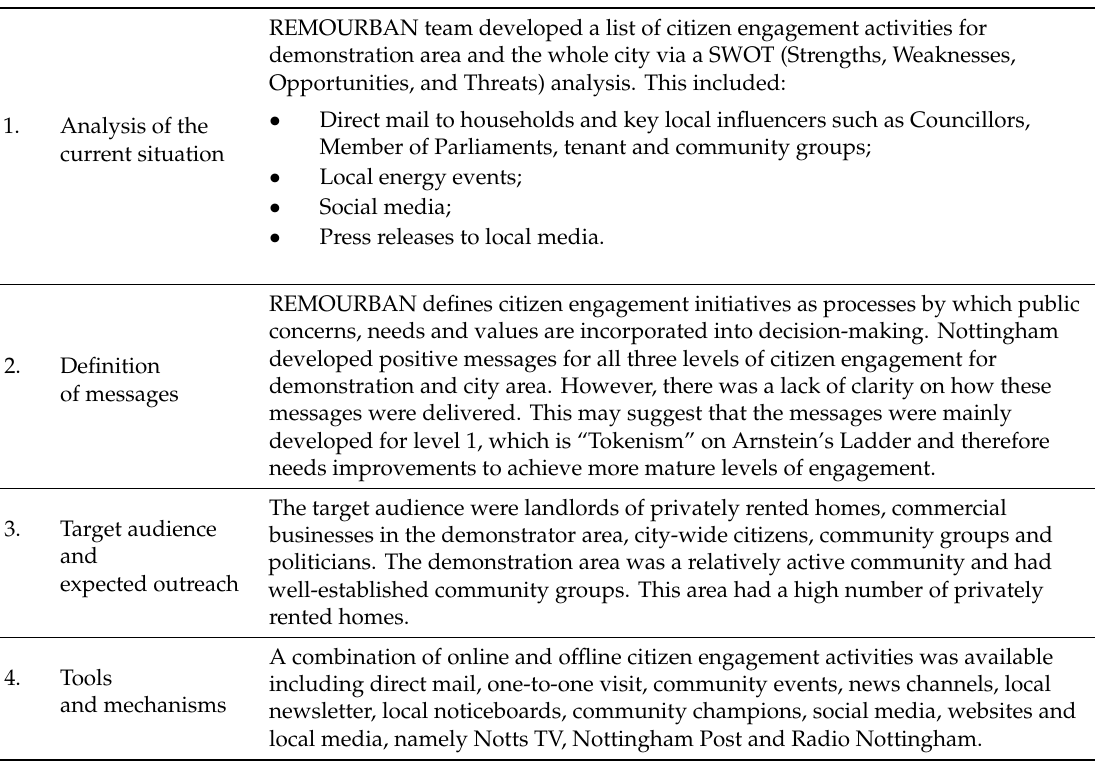
Table 3. Six steps for citizen engagement in Nottingham, adapted from [3].